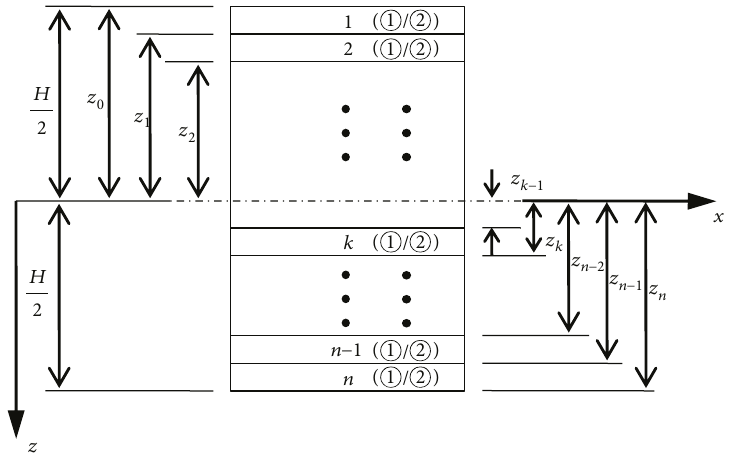
Figure 1: Model of hybrid